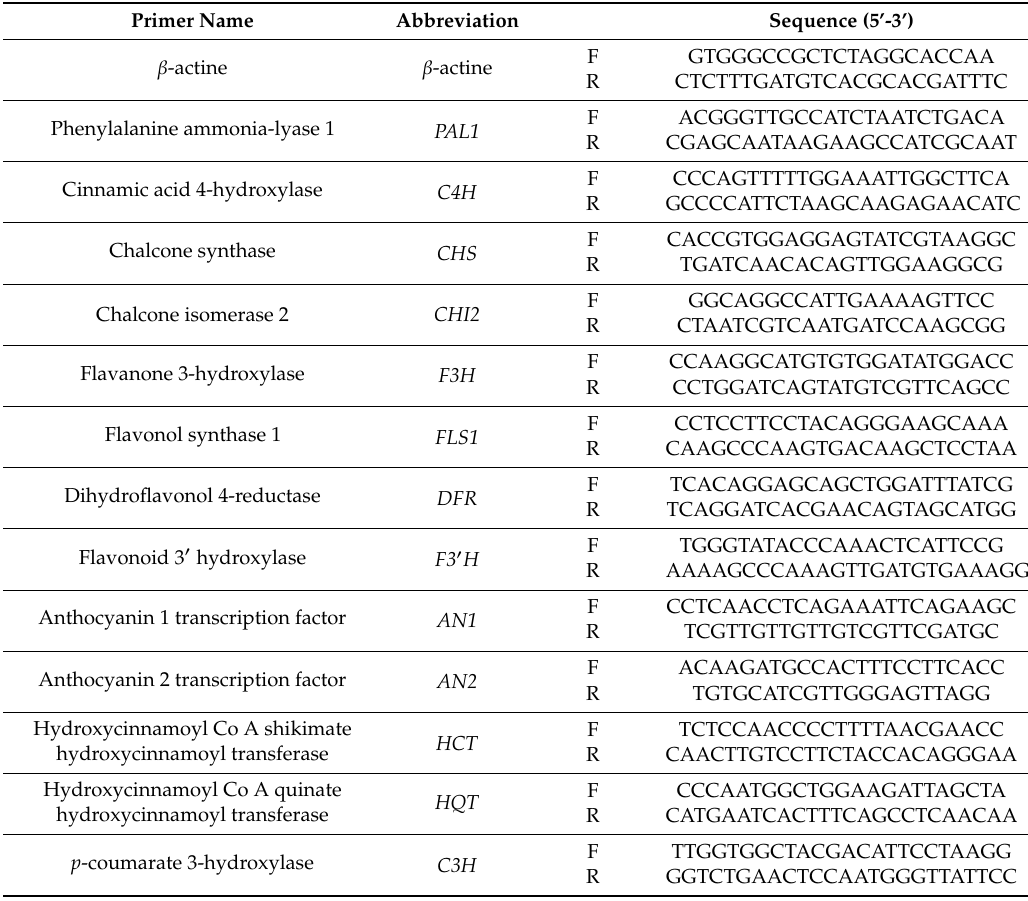
Table 1. Primer sequences of flavonoid and chlorogenic acid biosynthetic pathways